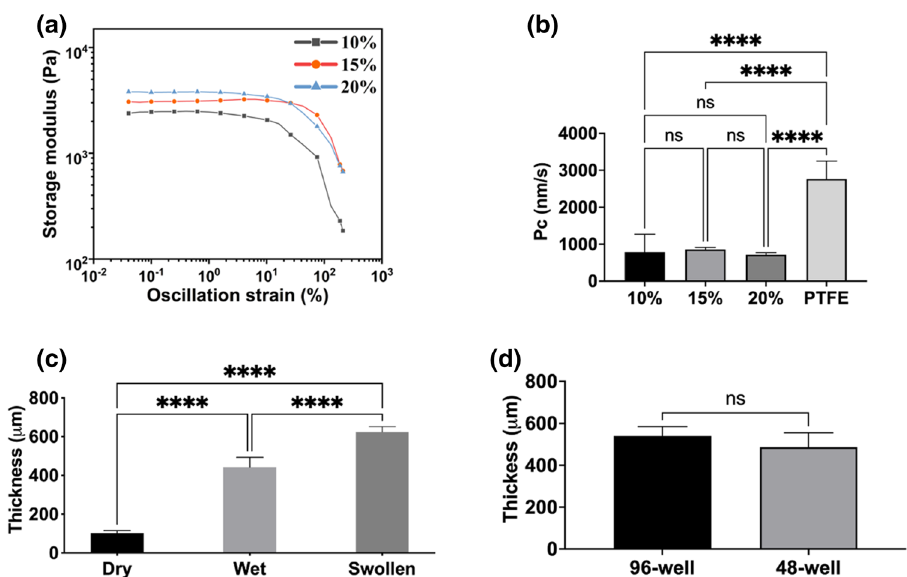
Figure 3. Determination of mechanical properties of 10% w/v (10%), 15% w/v (15%), 20% w/v (20%) gelatin membranes. ( a ) Analysis of storage and loss modulus of each membrane under applied oscillatory compression. ( b ) Comparison of 20 µM Fluorescein sodium salt dye transport through each membrane assembled to 96-well plate format 3D-printed strip insert wells (10–20%: n = 4; PTFE: n = 7). Insert well aperture surface area for transport is 0.05 cm 2 . ( c ) Determination of thickness changes of 15% (w/v) Gelatin membranes assembled to 48-well format (Ø: d = 8.8 mm; a = 4 mm); wet (n = 5), swollen (n = 5), and dry (n = 5). ( d ) Thicknesses measurement of 15% (w/v) gelatin membranes (n = 5) via fluorescence intensity analysis. Error bars indicate mean ± SD. Statistical significance: ns = P > 0.05, ****P <